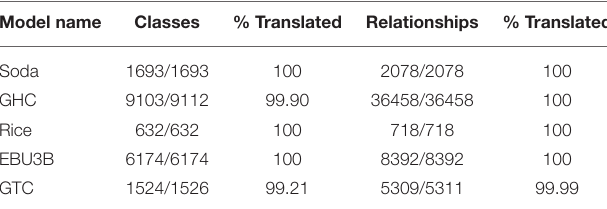
TABLE 4 | The completeness of the migration tool against five Brick reference models in terms of the instances of classes and relationships in the source model.